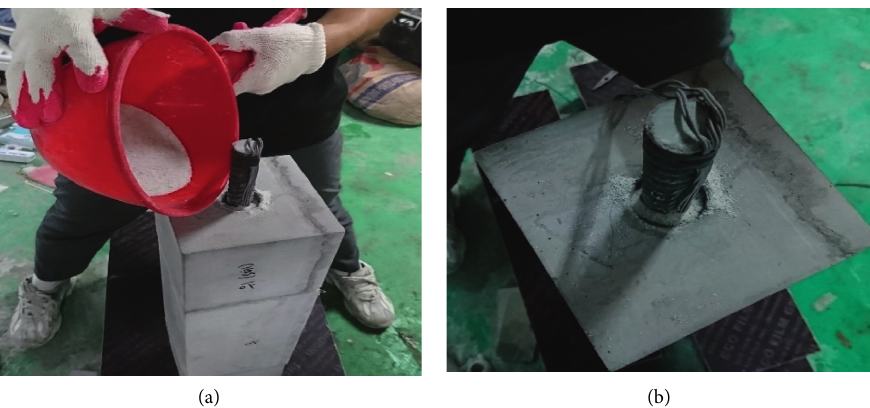
Figure 17: Installation of GFRP rock bolt sensor fixed with soil: (a) filling sand; (b) concrete block completely filled with sand.